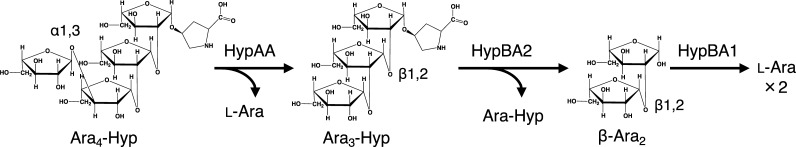
Glycosidic bond cleavage of the β-arabinooligosaccharide degradation system of B. longum JCM 1217.HypAA and HypBA2 are extracellular enzymes, and HypBA1 is an intracellular enzyme. An ABC-type transporter system specifically imports β-Ara2 into the cell.